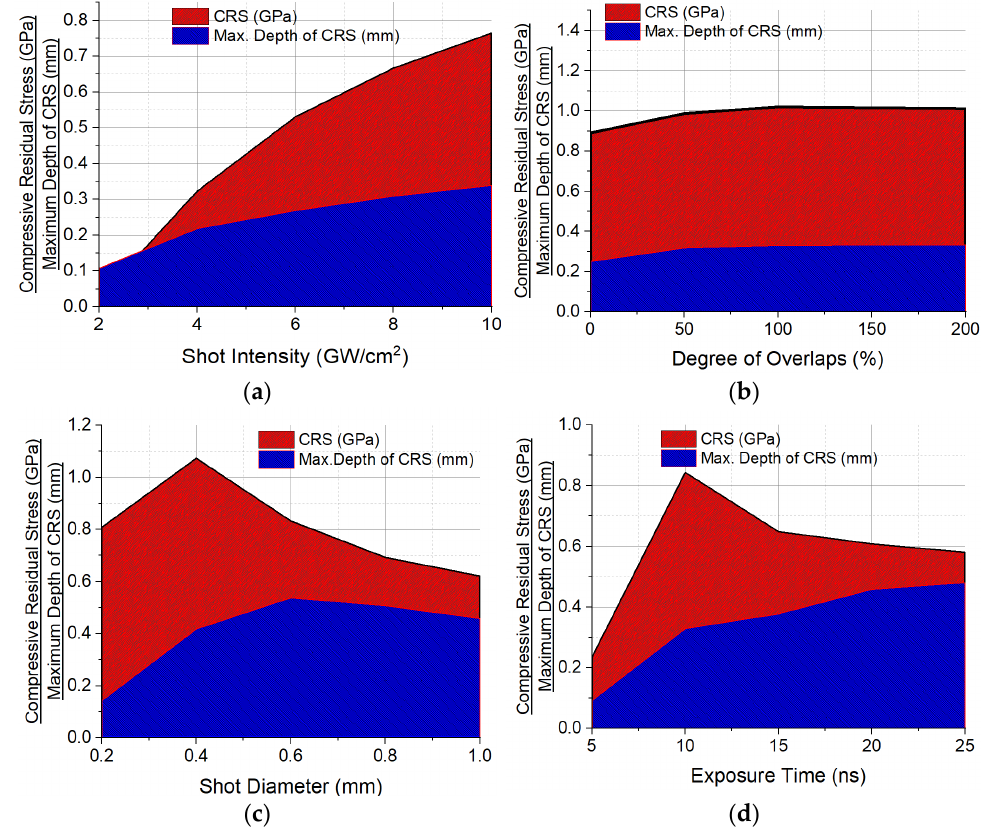
Figure 10. Parametric investigation of the effects of linearly increasing/decreasing magnitudes of the input parameters on residual stress enhancement. ( a ) Laser shot intensity. ( b ) Degree of shot overlap. ( c ) Shot diameter. ( d ) Exposure time.